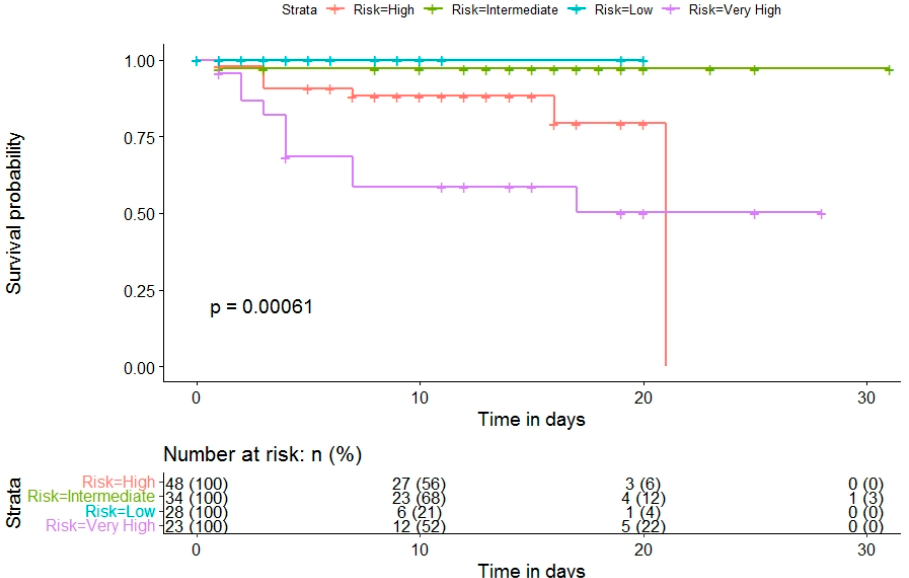
Figure 3. Kaplan–Meier survival curves of hospitalized COVID-19 patients: ( a ) according to 4C Mortality Score cutoff value of 11; ( b ) according to 4C Mortality Score cutoff value of 14.